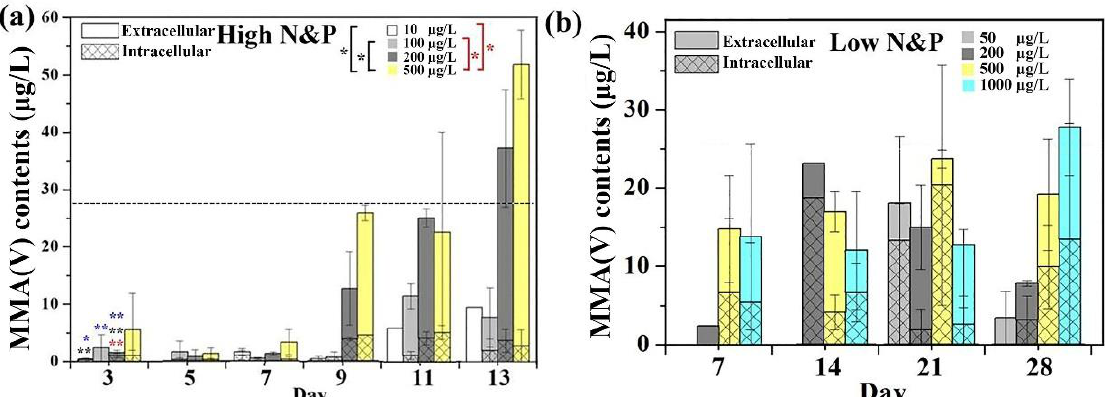
Figure 6. The intracellular and extracellular MMA(V) concentrations varied with incubation time that exposed different iAs(V) concentrations in the high ( a ) and low ( b ) nutrient sets. Note: Red and black * on the legend indicate significant variations of intracellular and extracellular MMA(V) concentrations with incubation time, respectively, between each of two groups of ambient iAs(V) concentrations; no significant variations between intracellular and extracellular MMA(V) concentrations were found in four groups of ambient iAs(V) concentrations. Red, black, and blue * on column bars indicate significant variations of intracellular, extracellular, and total MMA(V) concentration with incubation time for each group of ambient iAs(V) concentration. Significance levels below 0.05 (*) and 0.01 (**) are denoted in the figure. Line indicates value as the largest intracellular and extracellular MMA(V) concentration in the low nutrient set.